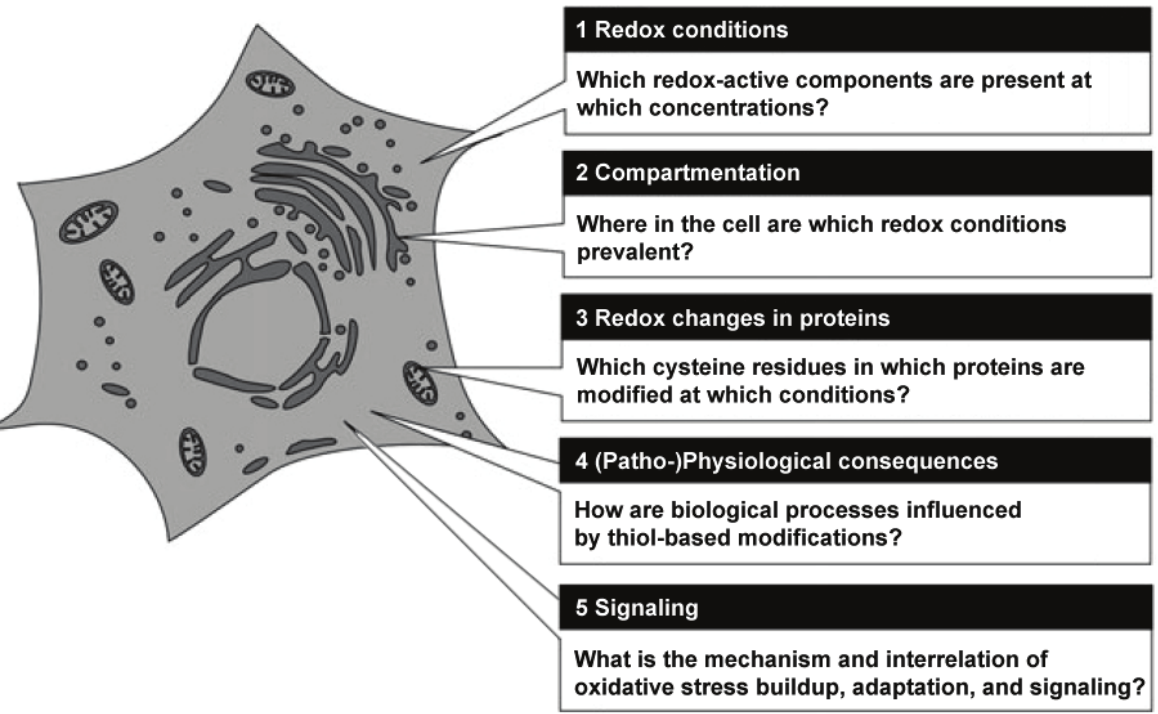
Figure 1. Central questions in redox biology. Source: Herrmann and Dick, Biological Chemistry 393, 999–1004 (2012) modified, with